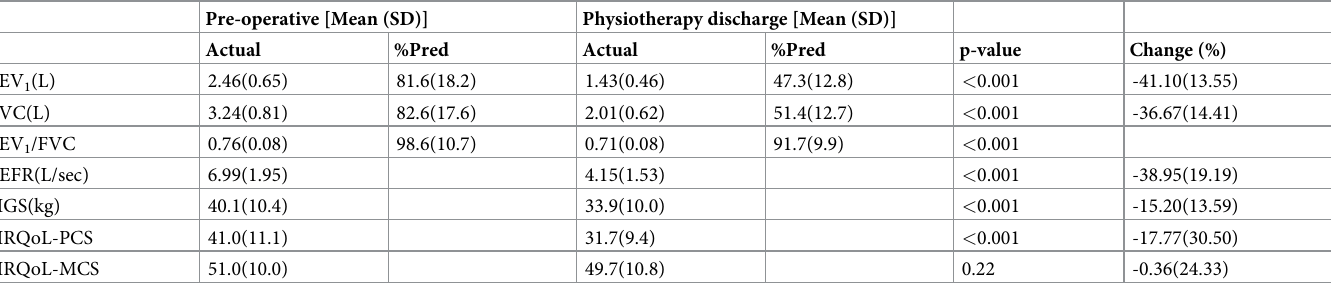
Table 2. Pre-operative and physiotherapy discharge values including change, for handgrip strength, lung function and health-related quality of life of participants. Pre-operative [Mean (SD)]